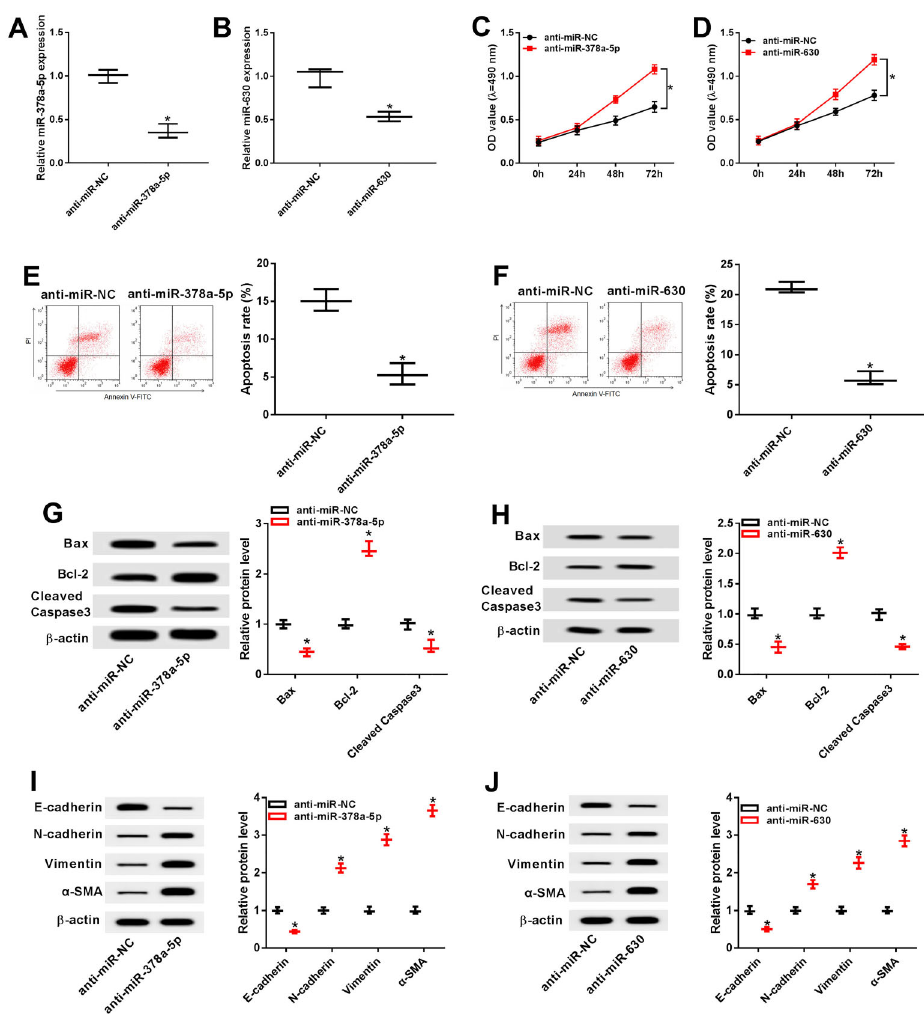
Figure 2. A and B , The expression of miR-378a-5p and miR-630 in transfected SRA01/04 cells was evaluated by qRT-PCR. C and D , Cell proliferation was measured by MTT assay. E and F , Cell apoptosis was analyzed by fl ow cytometry. G and H , Protein expression of Bax, Bcl-2, and cleaved caspase 3 in transfected SRA01/04 cells was determined by western blot. I and J , The protein levels of E-cadherin, N-cadherin, vimentin, and a -SMA were determined by western blot. Data are reported as means ± SD. *P o 0.05 ( t